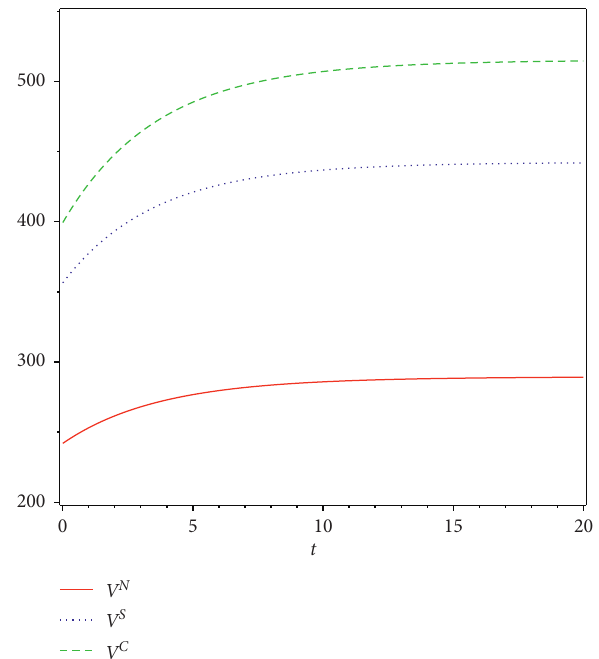
Figure 3: Revenue of the system of university-enterprise cooperation under three game